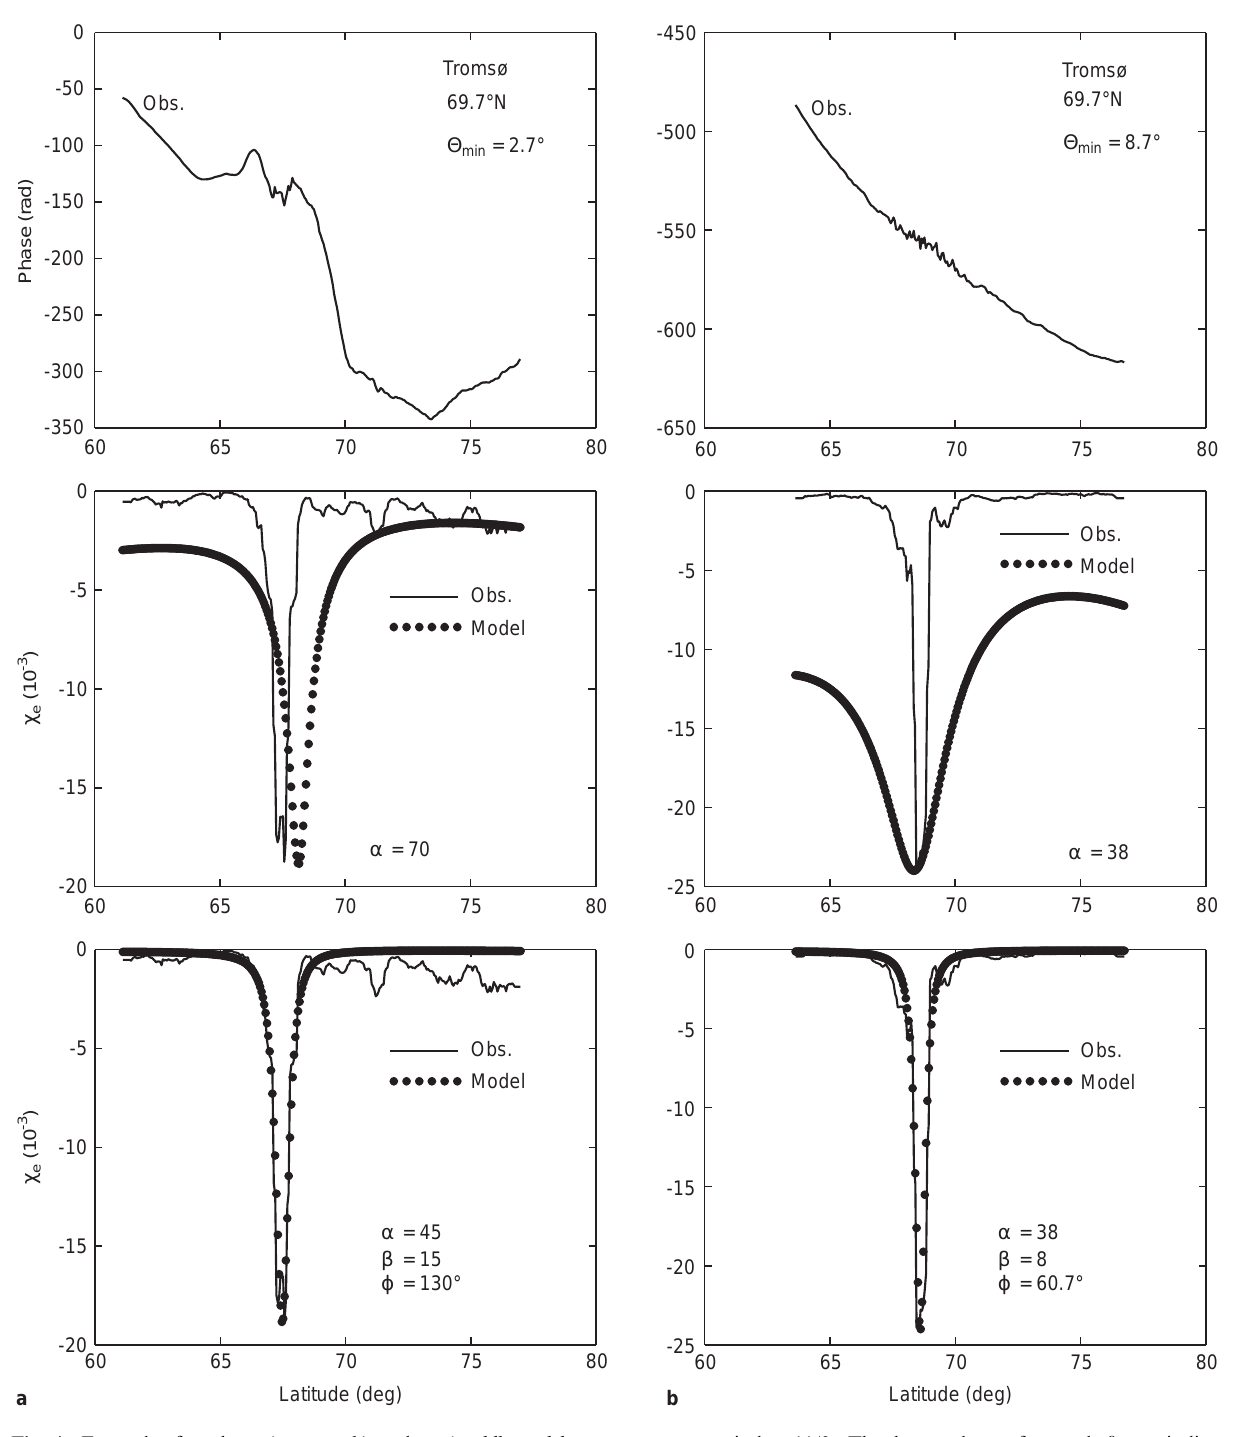
power index 11/3. The best values of a and b are indicated in Fig. 4. Examples for phase ( top panels ) and v ( middle and bottom e respective panels. In the bottom panels the orientation of the panels ) from two satellite passages at Tromsø ( continuous lines ) perpendicular anisotropy is given by u , which is the directional angle together with results of theoretical fits to the amplitude data ( dots ). of the horizontal projection of the axis of perpendicular anisotropy, The fits in the middle and bottom panels are obtained using spectra measured eastwards starting from which are symmetric and asymmetric around the geomagnetic field, respectively. In each case the spectral shape obeys power law with a